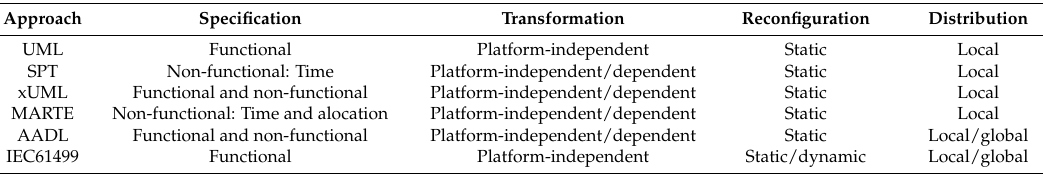
Table 3. Comparison of the modeling